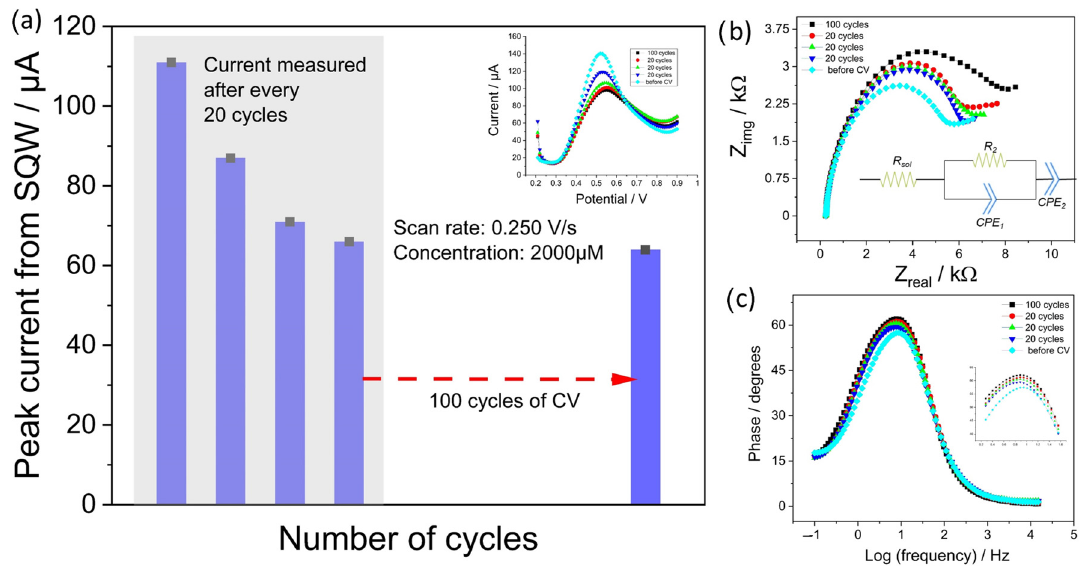
Figure 11. ( a ) bar graph depicting the decrease in peak current after every cycling phase and the inset shows the SWV curves, ( b , c ) shows the Nyquist and phase plots of the electrode respectively and the inset in Figure 11b shows the equivalent circuit model implemented for fitting the spectra.